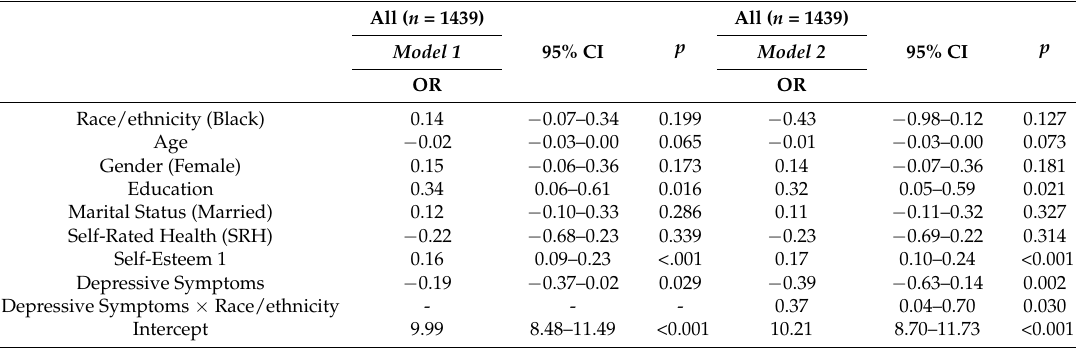
Table 3. Association between baseline depressive symptoms (2001) and subsequent change in self-esteem (2001–2004) using linear regression models in the pooled